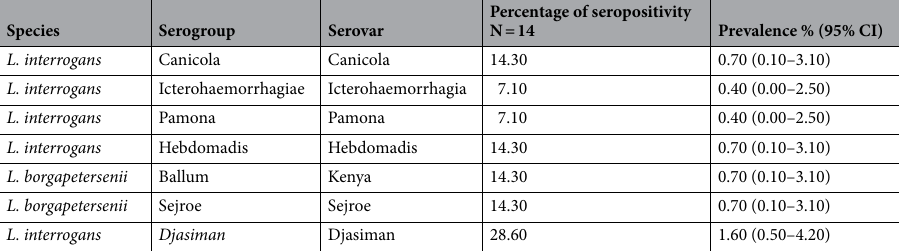
Table 2. Prevalence of leptospirosis by serovar table. CI—stands for confidence interval.